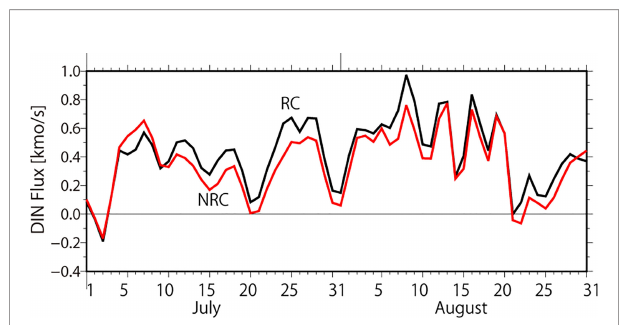
FIGURE 13 | Temporal variation in the DIN fl ux across 32.92°N shown by the red line in Figure 1B . Black and red lines in show the variation in the rain (RC) and no-rain (NRC) cases,